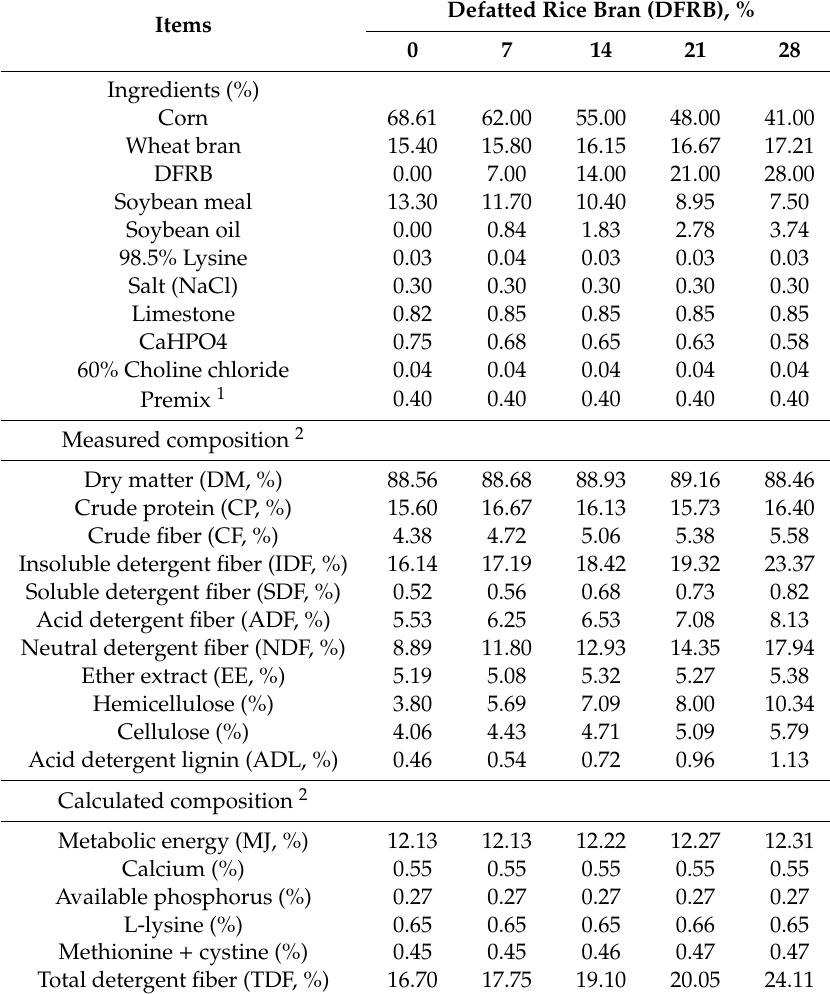
Table 1. Composition of experimental